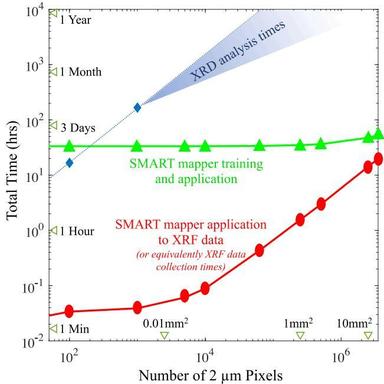
Plot of time vs number of pixels (or area) for the SMART mapper application with training in green (triangles), direct SMART mapper application to XRF data in red (circles), and for a hypothetical pixel-by-pixel approach in blue (diamonds). This analysis assumes image resolution of 2 μm, 200 coupled data point analyses for mapper training, 10 min to analyze a single XRD pattern, and XRF dwell times of 20 ms. (For interpretation of the references to color in this figure legend, the reader is referred to the